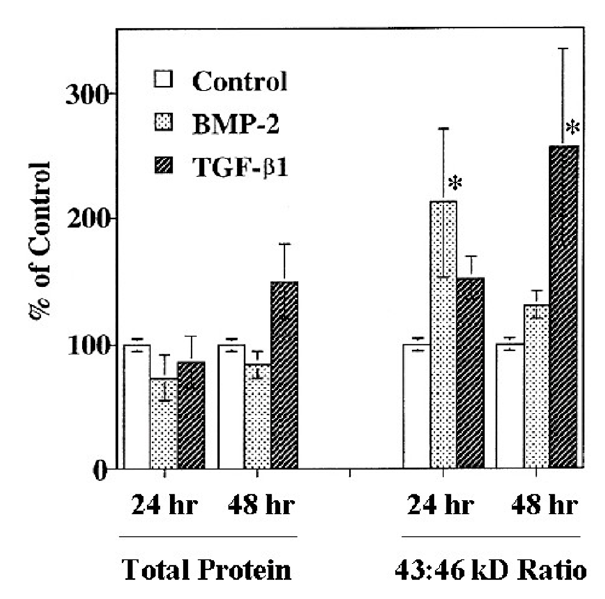
Figure 3 Densitometric analysis of Cx43 expression. Total Cx43 pro- tein expression (left) and the ratio of the 43 kD: 46 kD bands (right) normalized to control levels. Values are mean ± S.D. of 3 separate experiments with control set at 100% ( * p < 0.05 compared to